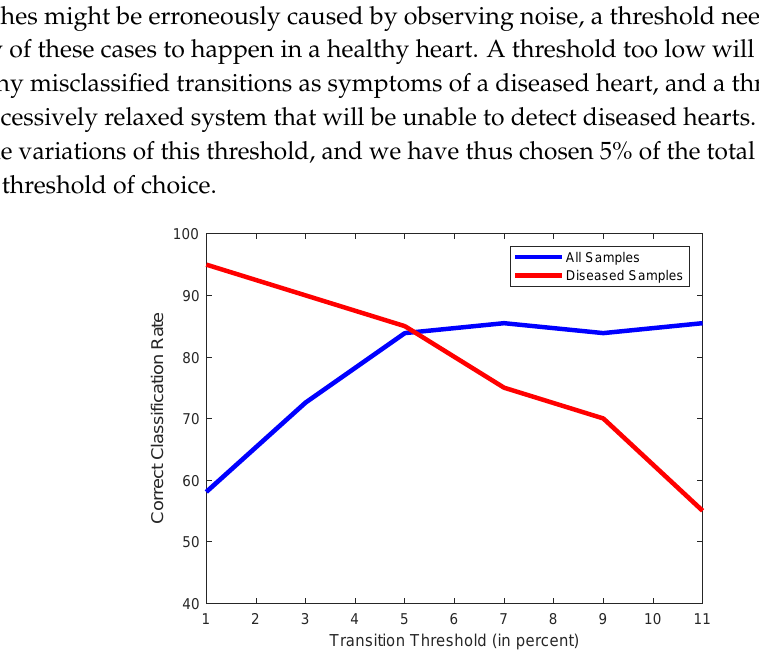
Figure 12. Plot of classification accuracies of all samples (blue) and only diseased samples (red) vs. Open/Close Threshold (in percent of Total No. of Frames).